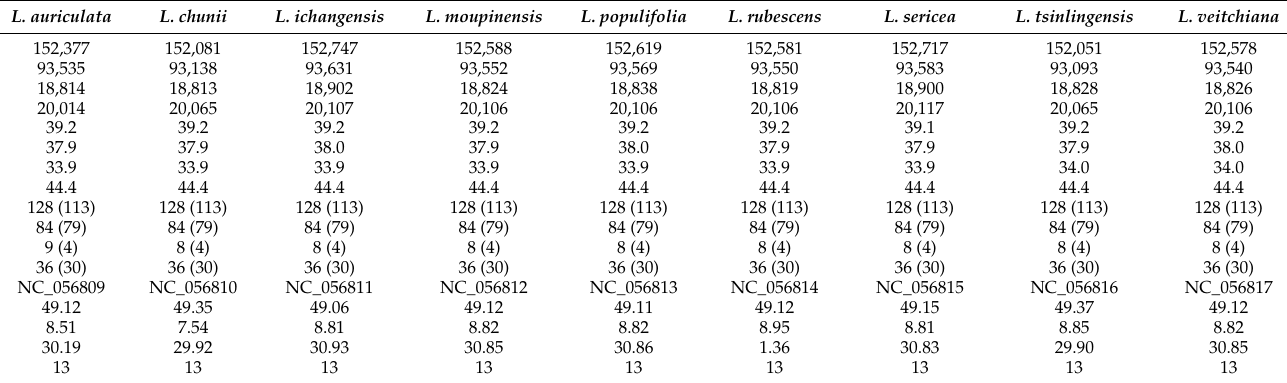
Table 2. Chloroplast genome features of nine species of Litsea